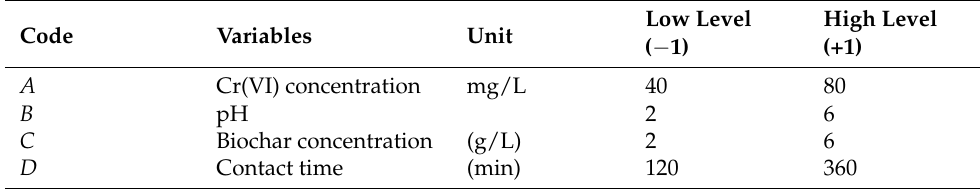
Table 1. BBD response surface test design table.